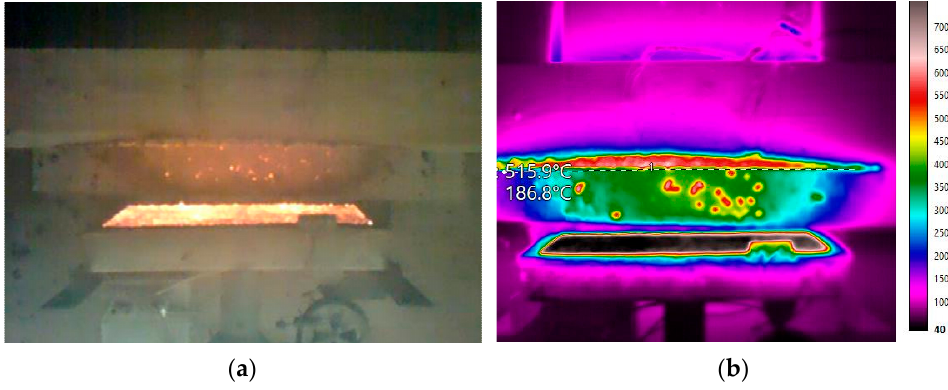
Figure 4. The outputs from optical ( a ) and thermal ( b ) imaging camera.